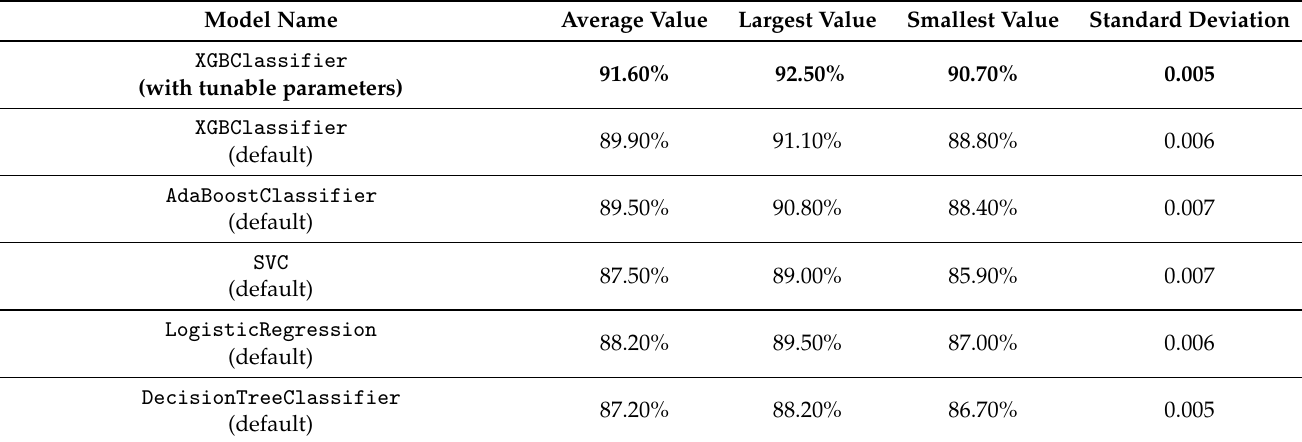
Table 3. Results of individual algorithms.